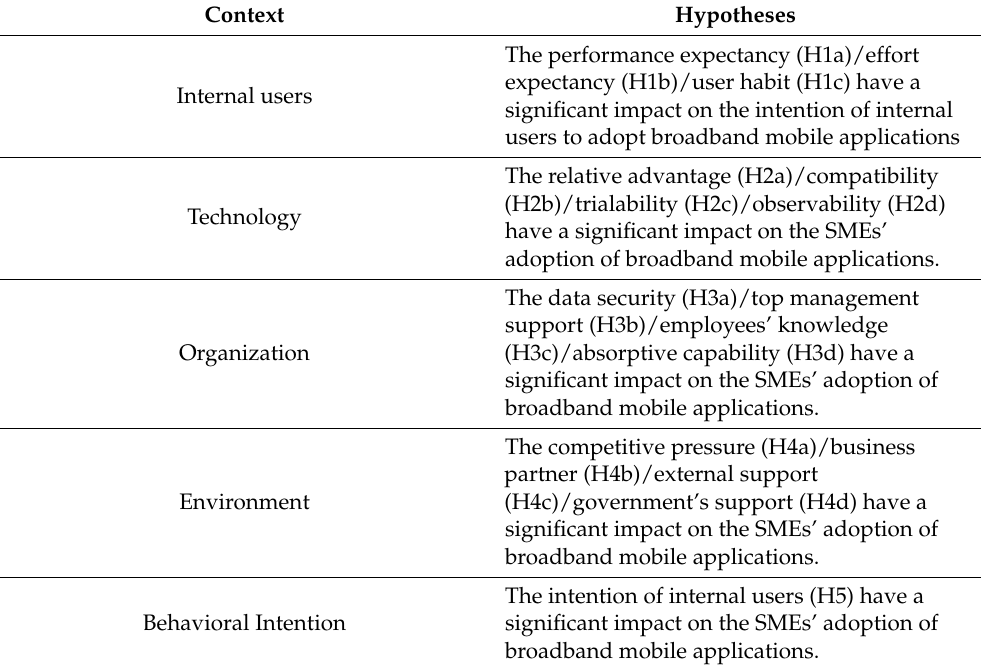
Table 2. Research